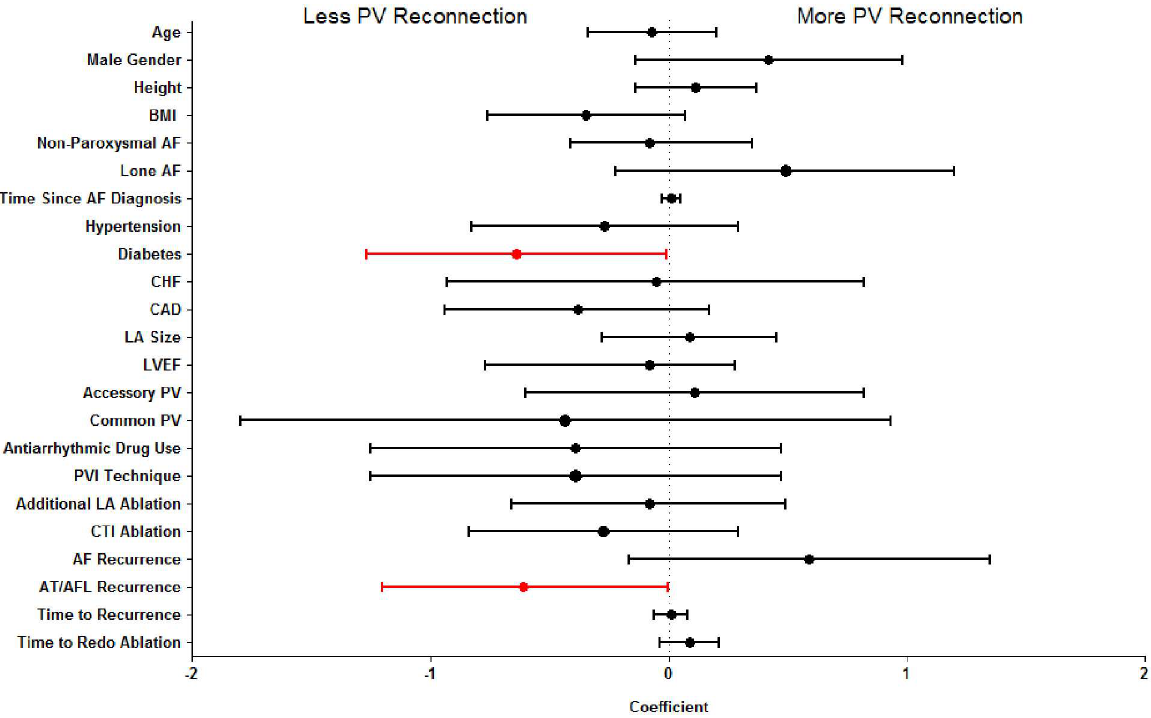
Fig 2. Presentsthe association with PV reconnection analyzed by univariate ordinal regression for subjects with 1–4 PVs reconnected. Negativecoefficientsindicate an association with less PV reconnection and positive coefficients indicatean association with more PV reconnection. P < 0.05is displayedin red.